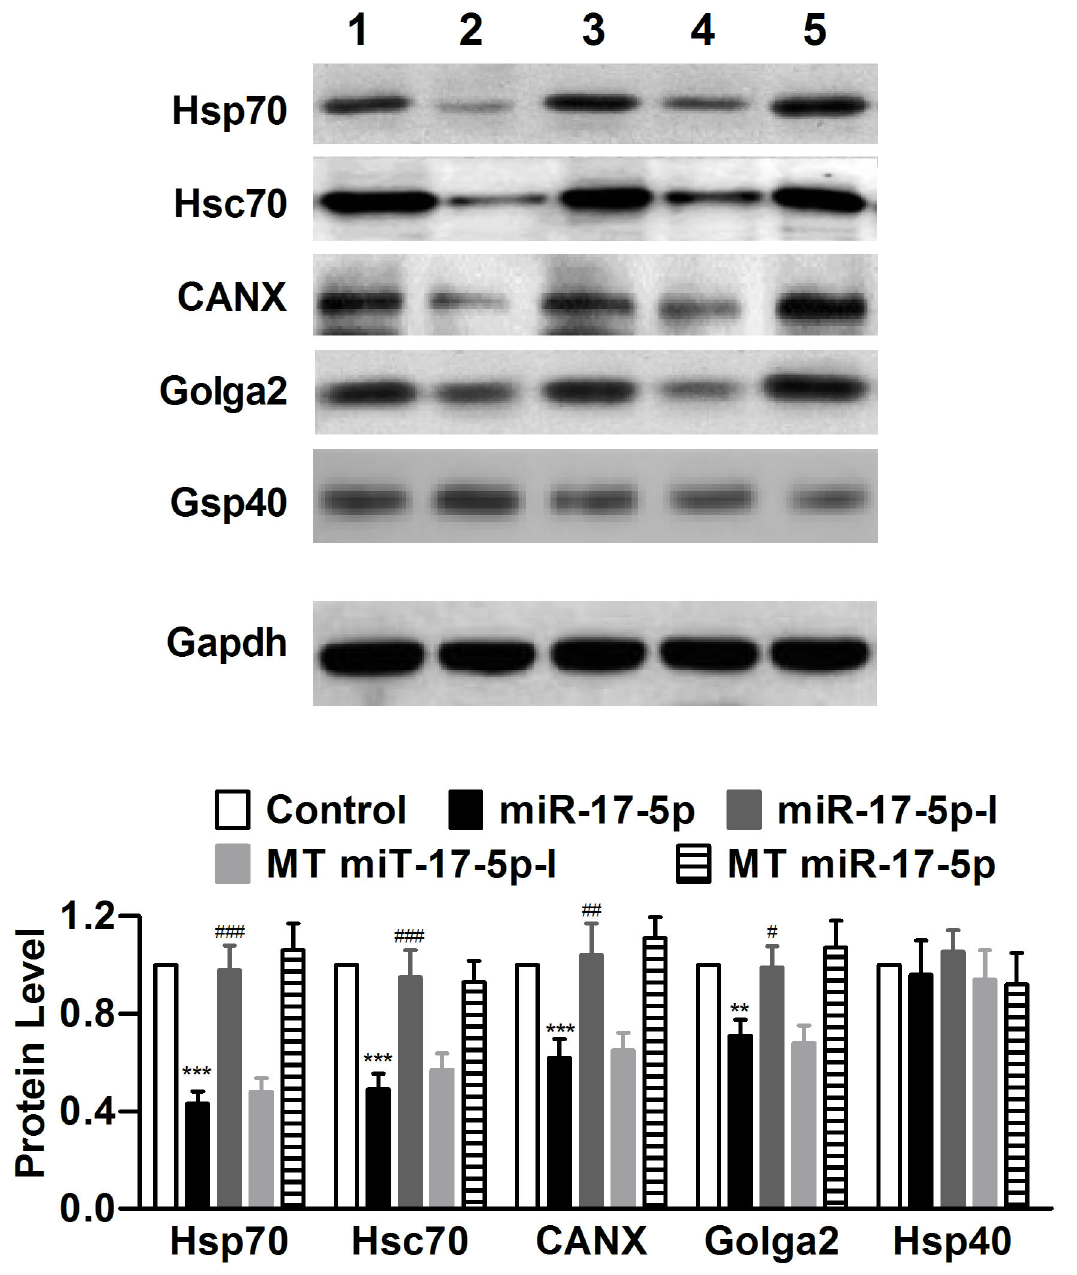
Figure 3. Experimental verification of Hsp70, Hsc70, CANX, and Golga2 as target genes of miR-17-5p by Western blot analysis in neonatal rat ventricular myocytes (NRVMs). miR-17-5p-I: miR-17-5p inhibitor (it was co-transfected with miR-17-5p mimic); MT miR-17-5p: mutant miR-17-5p; MT miR-17-5p-I: mutant miR-17-5p inhibitor. Hsp40 was used as a negative control for the target chaperones, and MT miR-17-5p and MT miR-17-5p-I were used as negative controls for miR-17-5p. *** P <0.001 miR-17-5p vs Control; n=6; # P <0.05, ## P <0.01 & ### P <0.001 miR-17-5p-I vs miR-17-5p.